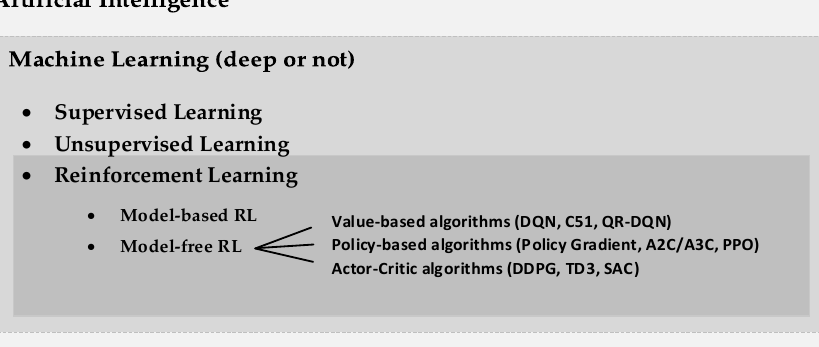
Figure 1. The family of machine learning techniques.